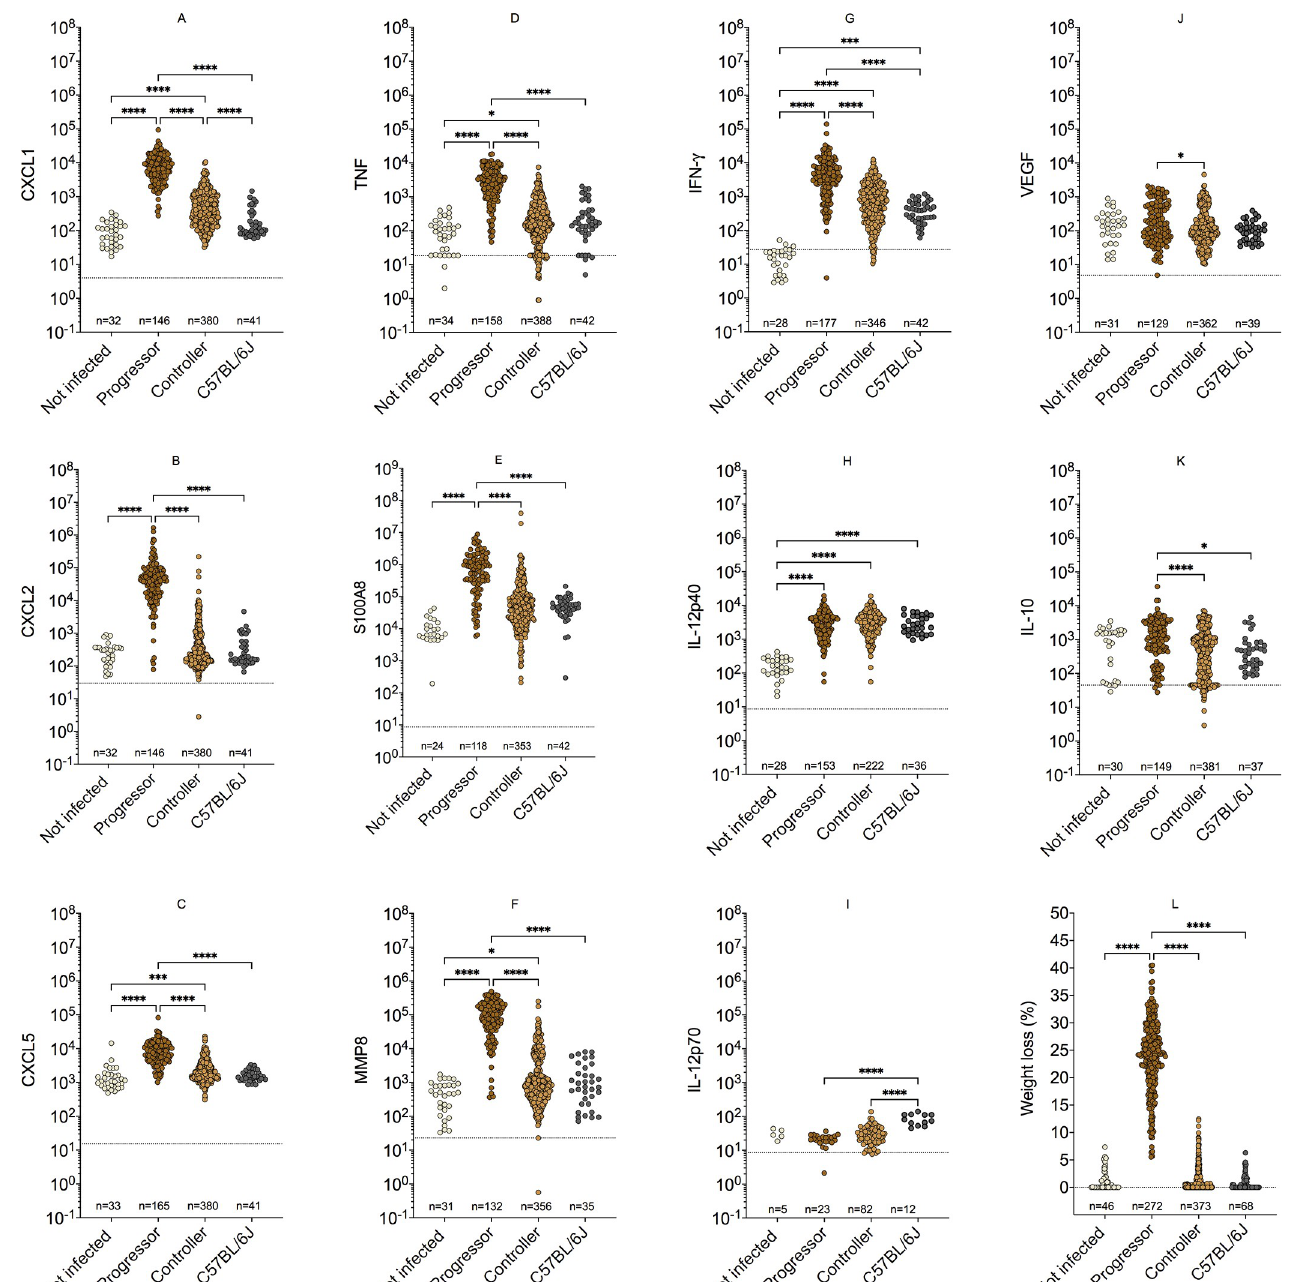
Fig 3. Lung proteins and weight loss in Mtb- infected mice. We infected 8-10-week-old, female DO (n = 395) and C57BL/6J (n = 42) mice with Mtb bacilli by inhalation over 5 independent experimental infections to generate data shown in panels A-K. All progressor DO mice were euthanized by 60 days of Mtb infection due to the development of any one of three IACUC-approved early removal criteria: body condition score < 2; severe lethargy; or respiratory distress (i.e. increased respiratory rate and effort). The non-infected DO mice, controller DO mice, and C57BL/6J showed no morbidity. We measured lung protein biomarkers using sandwich ELISAs (A-K). In panel (L), weight loss was calculated for each mouse as a percent of its peak body weight from the same 5 independent experiments plus 1 additional experiment for which lung protein data was not available. All data were lognormal distributed and analyzed by Kruskal-Wallis one-way ANOVA with Dunn’s multiple comparisons post-tests ( � p < 0.05; �� p < 0.01; ��� p < 0.001; ���� p < 0.0001). Each dot repsesents 1 mouse.